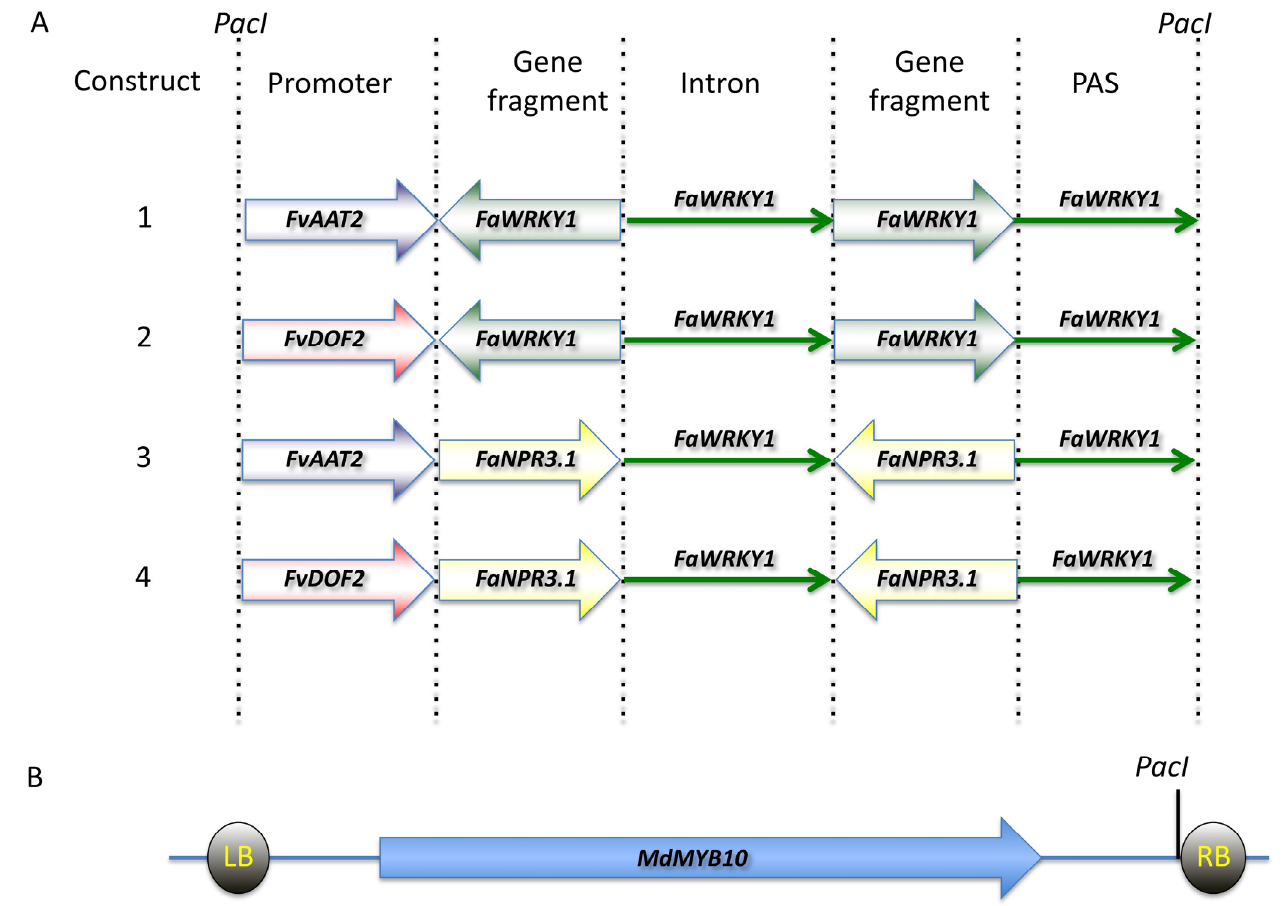
Figure 1. Creation of the Ti-plasmid constructs carrying the strawberry intragenic dsRNA silencing cassettes. ( A ) Design of the four intragenic-dsRNA-silencing cassettes. Promoter: promoter and regulatory sequences upstream from the ATG codon from genes FvAAT2 and FvDOF2 ; Gene fragment: DNA fragment from genes FaWRKY1 (272 bp) and FaNPR3.1 (407 bp) used for their corresponding inverted target sequences; Intron: the unique intron sequence of FaWRKY1 (652 bp); PAS: a 352 bp DNA fragment downstream from the stop codon of the FaWRKY1 , containing the predicted regulatory signals for the cleavage and polyadenylation signal; AscI and PacI , restriction site sequences flanking the entire intragenic-dsRNA-silencing cassettes. ( B ) The T-region of plasmid pMinMYB carrying the complete genomic sequence of the apple MdMYB10 gene (adapted from Krens et al. 2015). The position of the unique PacI restriction site used for cloning each of the four intragenic-dsRNA-silencing cassettes is shown. LB and RB, left and right border.